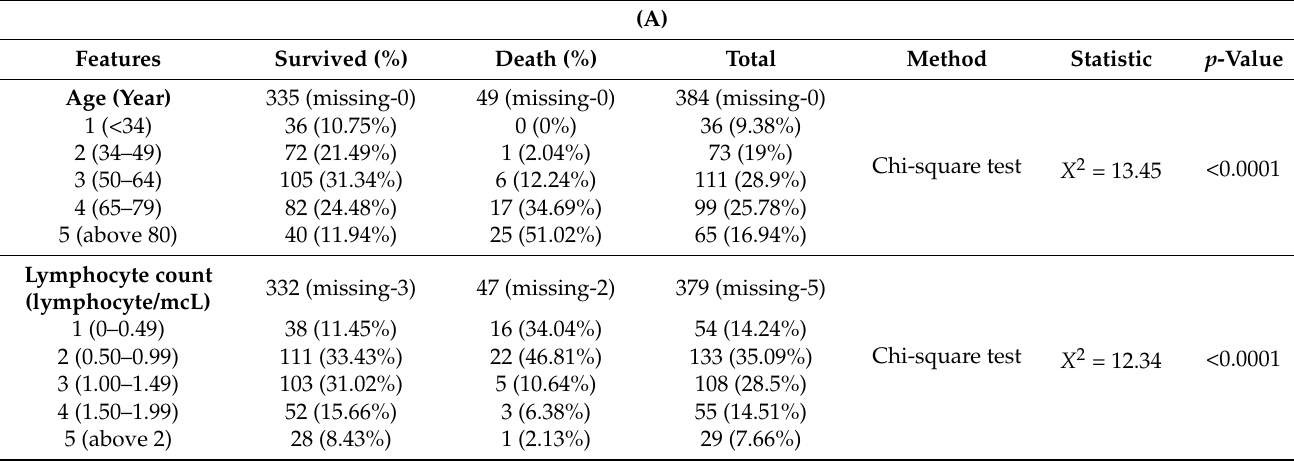
Table 2. Statistical Analysis of the Characteristic of the subjects’ data for ( A ) Dataset-1 and ( B )